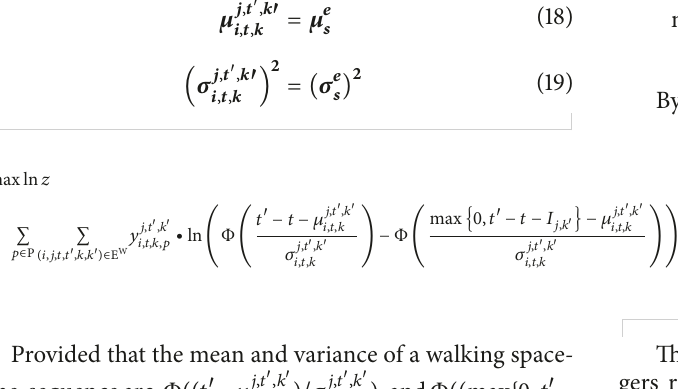
Algorithm 1 (iterative optimization algorithm). Input: